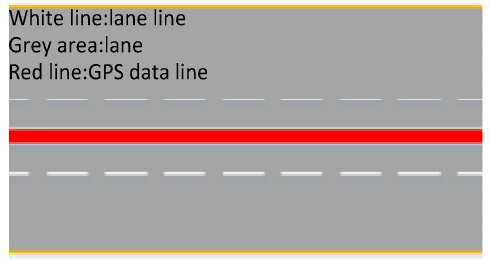
Figure 2. The general map has only one Global Positioning System (GPS) data line.